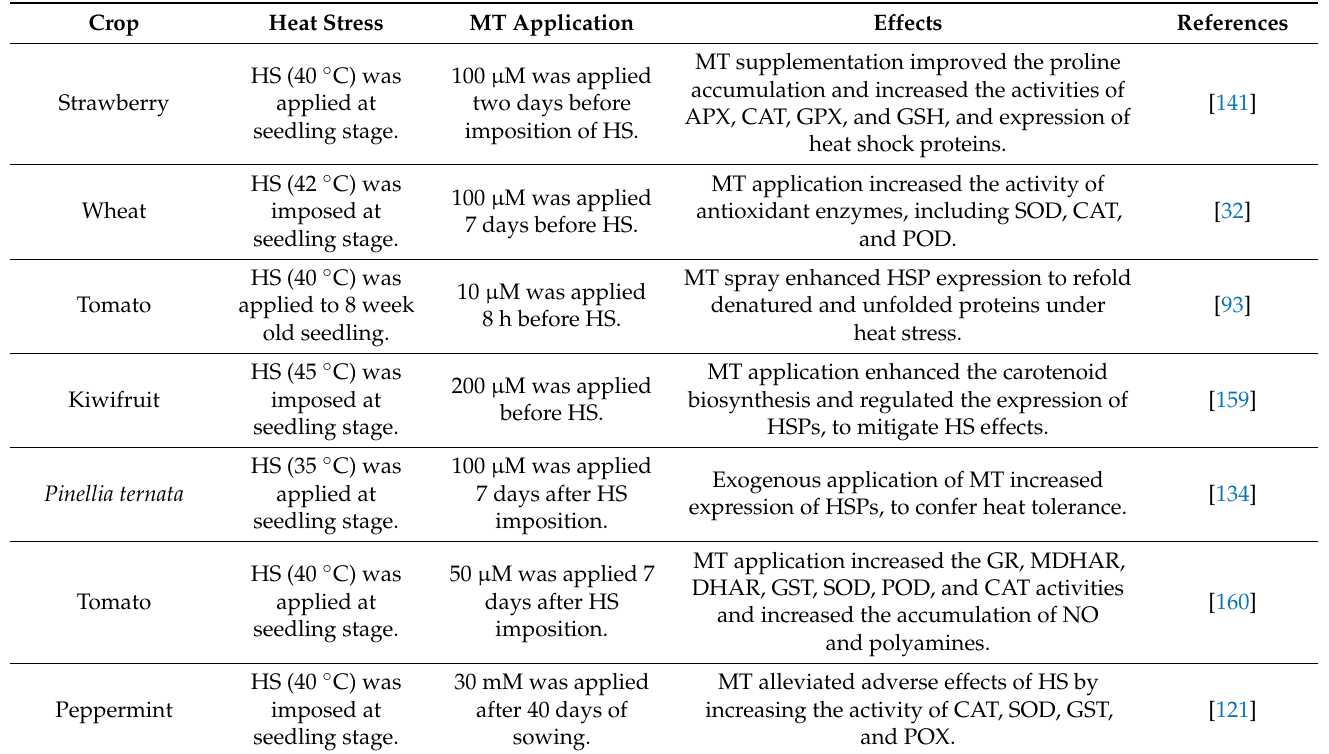
Table 4. Effect of melatonin on the accumulation of various osmolytes, antioxidant activities, and gene expressions under heat